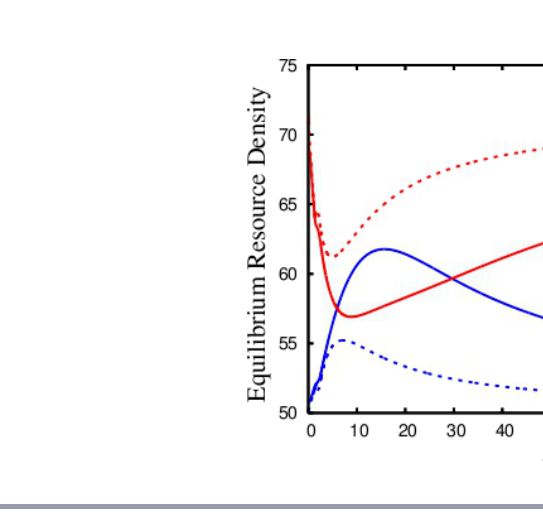
in Regions 1 (blue) and 2 (red) for a m